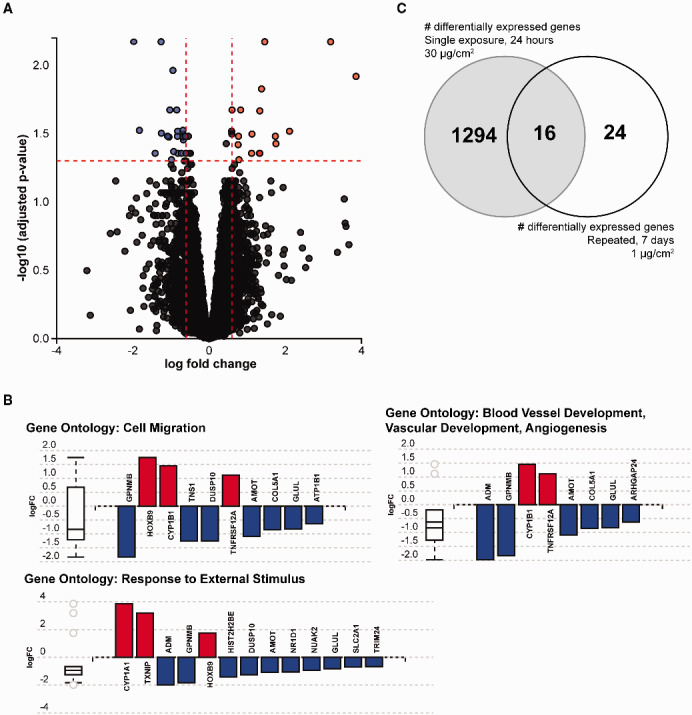
differential expression of genes after repeated, low-concentration exposure with PM2.5. BEAS-2B cells were treated with a fresh dose of 1 µg/cm2 of PM2.5 on a daily basis for six consecutive days. Cells were washed each day between consecutive treatments. At day seven, cells were isolated for RNA analysis and gene expression changes by fold-change and adjusted P-value are shown in the volcano plot (A). (B) Enrichment analyses identified specific gene ontologies that were enriched among the differentially expressed genes after repeated low-concentration exposure. (C) Comparison of differentially expressed genes after a single 24-h exposure with 30 µg/cm2 of PM2.5 and differentially expressed genes after repeated exposure to low-concentration PM2.5 identified a number of overlapping and non-overlapping genes.